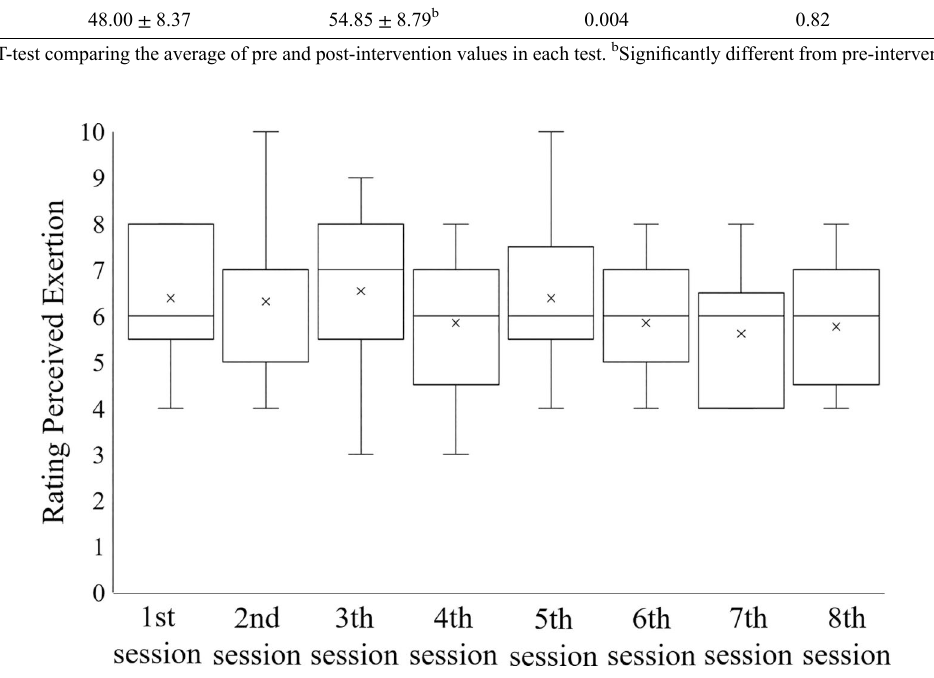
Figure 3 - Rating Perceived Exertion 30-min post each training session.